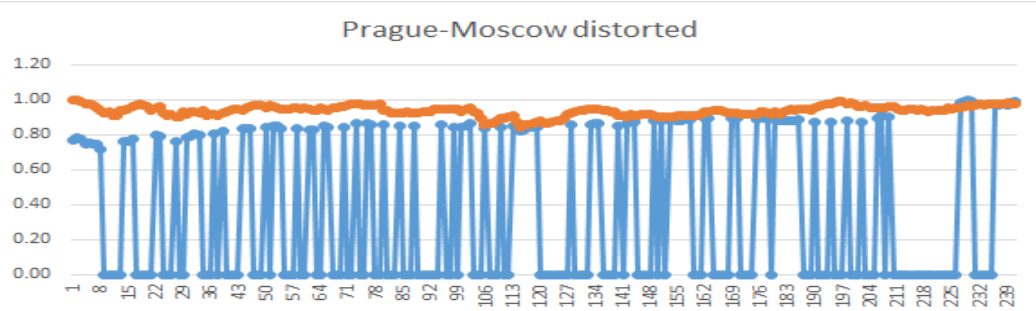
Figure 8. Comparison of graphs of Prague and artificially distorted Moscow stock prices; S ( Prague,Moscow-distorted ) =